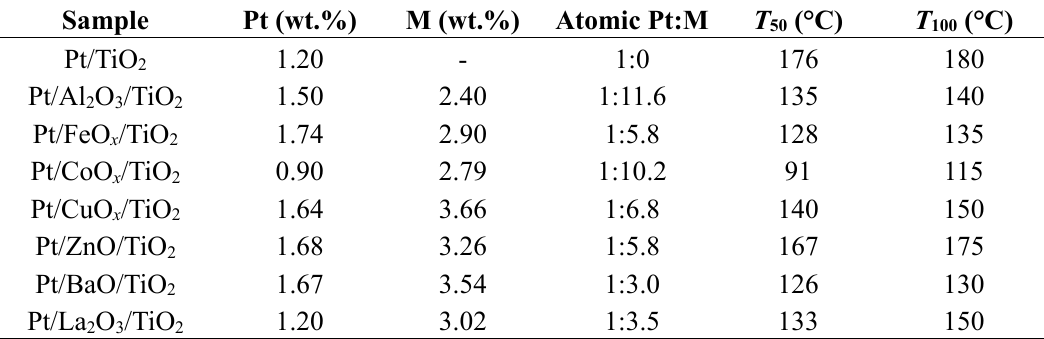
Table 2. ICP results, T 50 , and T 100 for Pt/MO x /TiO 2 catalysts.